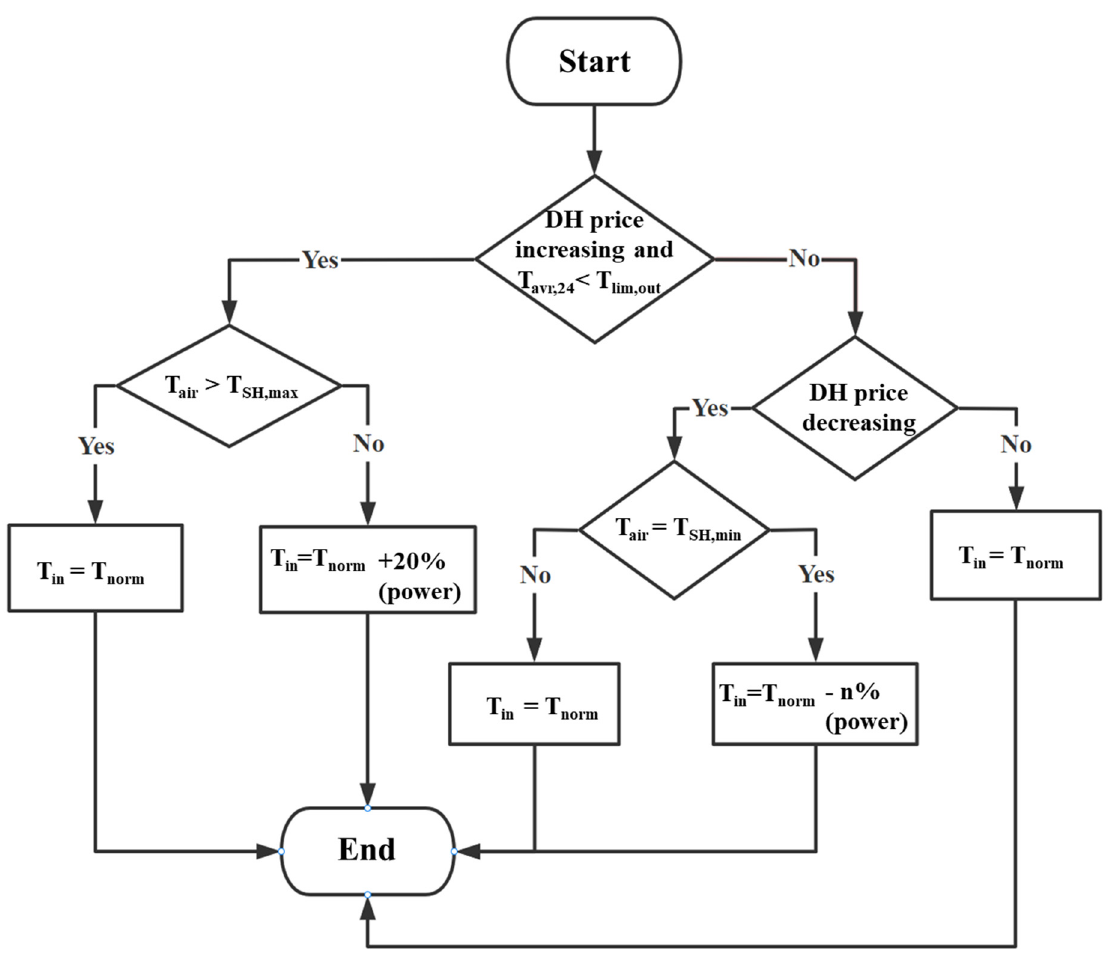
Figure 7. The centralized DR control of space heating.